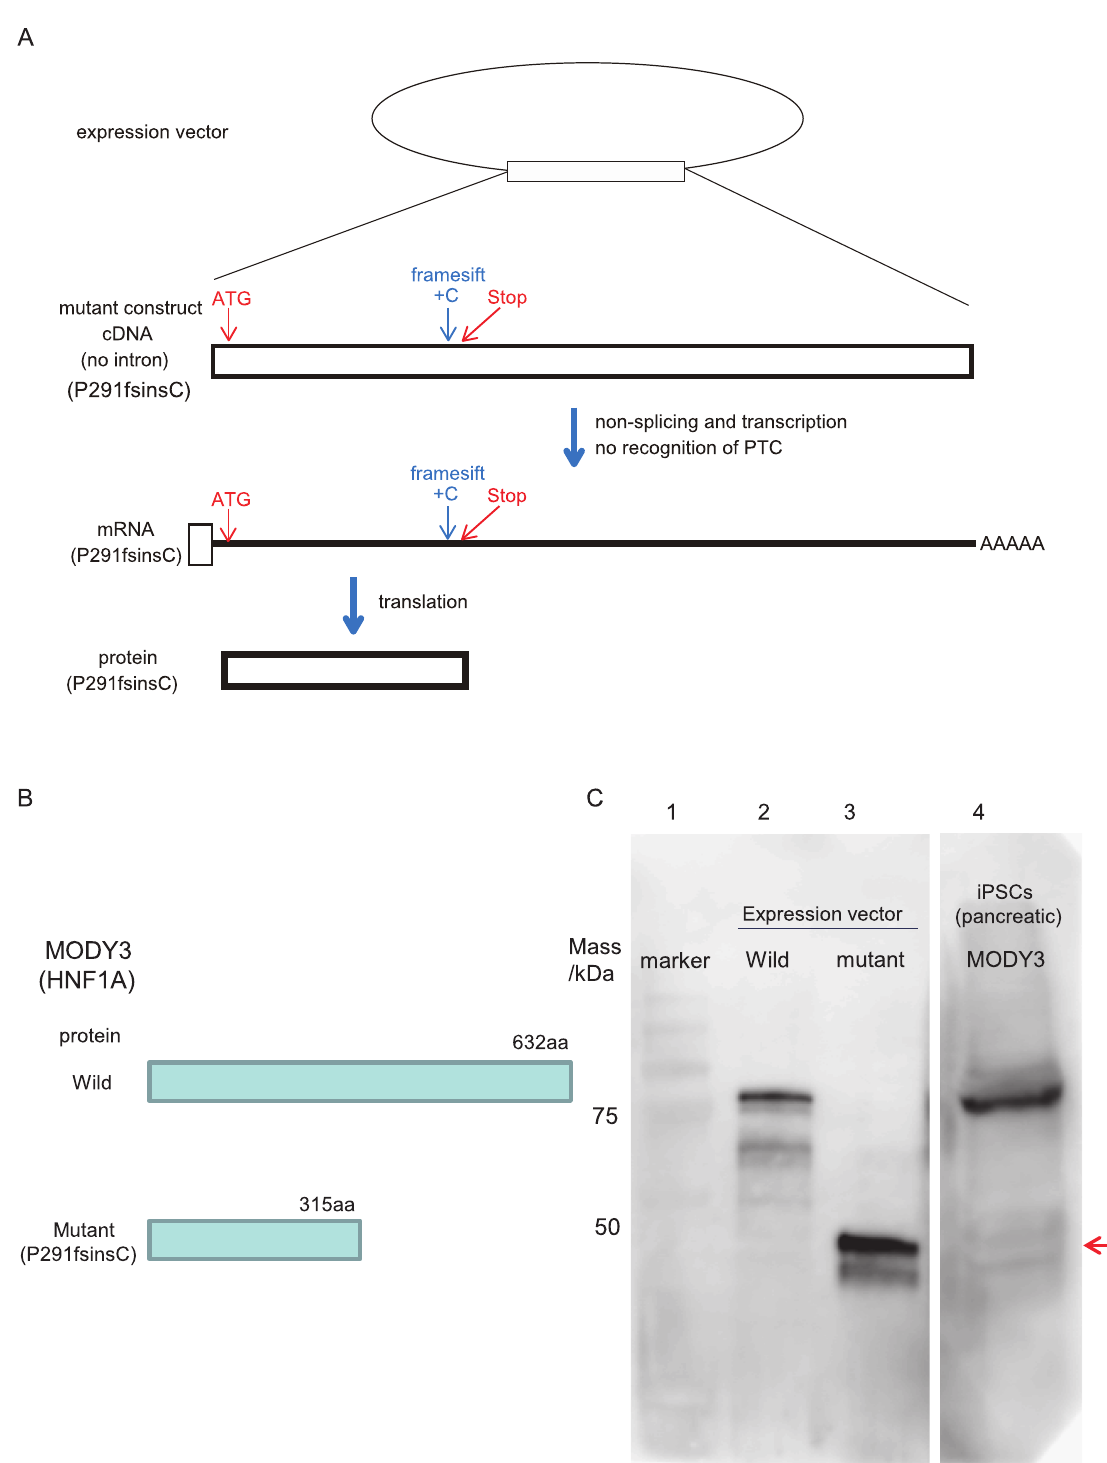
Fig 5. Wild or mutant protein expression of MODY3-iPS-beta cells. (A) Transcriptional and translational schema of P291fsisnC mutant gene artificially constructed in the expression vector. (B) Putative amino acid number for wild and mutant HNF 1A. (C) Western blot analysis of wild or mutant protein expression in vitro or ex vivo. Lane1; molecular marker, lane2; lysates of lentiX 293T cells transfected with wild type HNF1A gene, lane3; lysates of LentiX 293T cells transfected with P291fsinsC HNF1A mutant gene, lane4; pancreatic beta cells differentiated from MODY3-iPS cells. The amount of sample protein loaded on each lane in the gel was as follows: lane2; 1.6 μ g, lane3; 0.012 μ g, lane4; 80.0 μ g. Arrow indicated position of mutant protein band. Predicted band size: wild type; 81 kDa, mutant; 35 kDa.